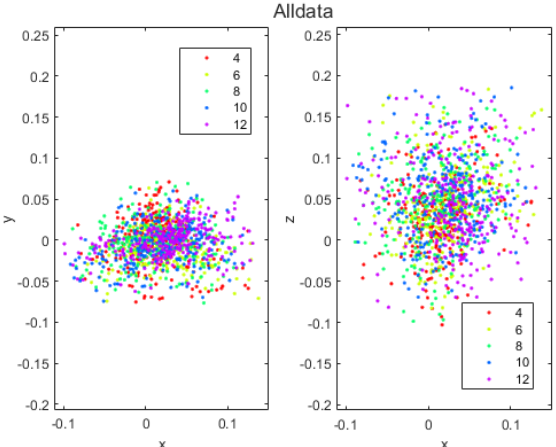
Figure 12 . Scatter plot of the residuals for all the benchmarks, all the operators and all the considered rover-façade distance values.